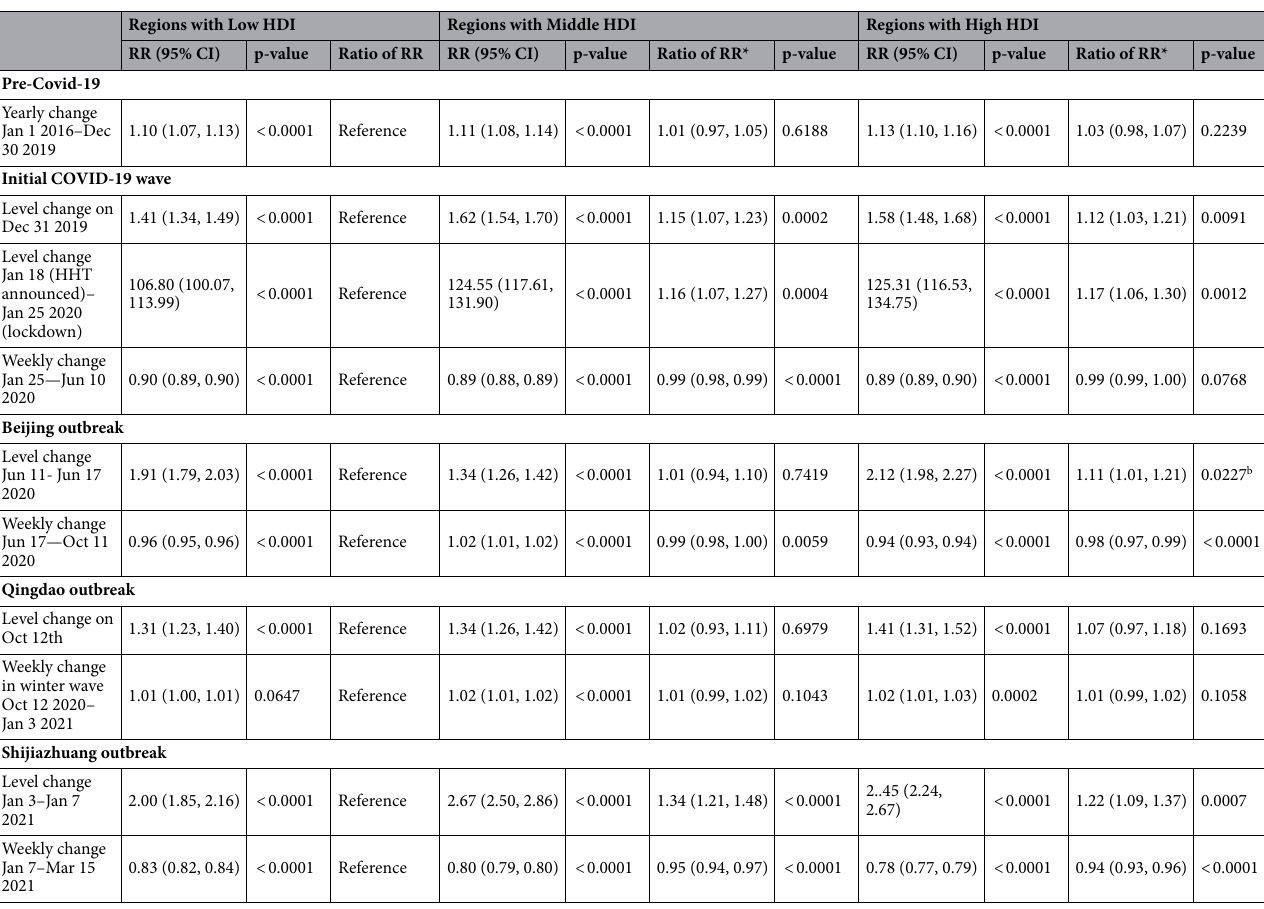
Table 2. Model estimated change of search index by HDI categories. *In reference to the low HDI category. b Not significant, after applying Holm-Bonferroni adjustment to maintain a family-wide type I error rate of 0.05 (All p values for the tests that are not marked “b” are significant unless they are greater tan